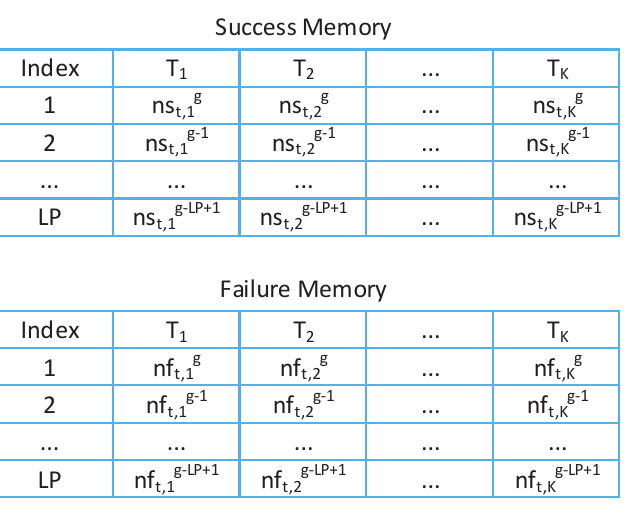
Figure 1. Task T t ’s success memory and failure memory for its K knowledge sources during the last LP